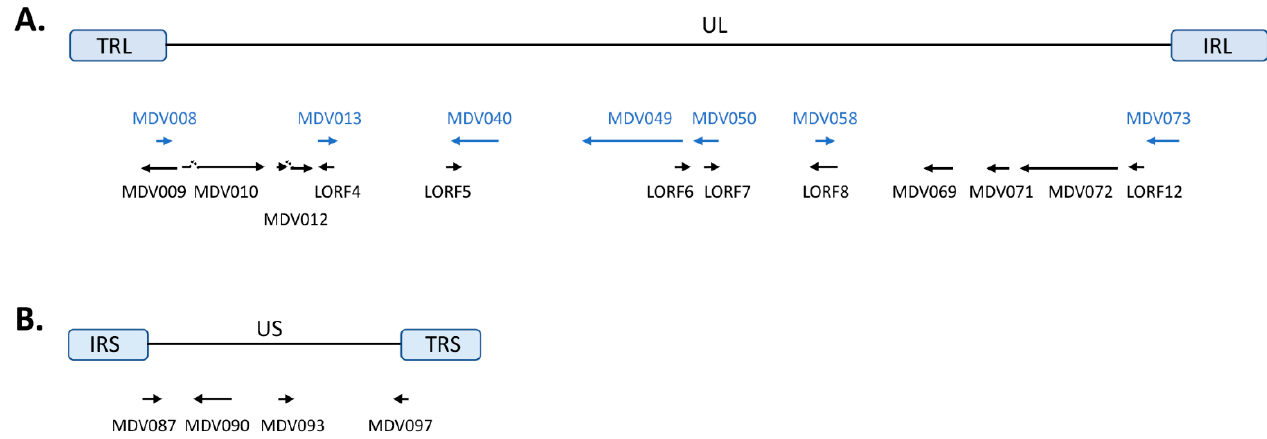
Figure 1. Genome structure and location of MDV unique open reading frames (ORFs). ( A ) MDV unique ORFs in the UL region of the Md5 strain are presented. Overlapping ORFs, displayed in blue, are also presented. ( B ) MDV unique ORFs in the US region of Md5 strain are presented.